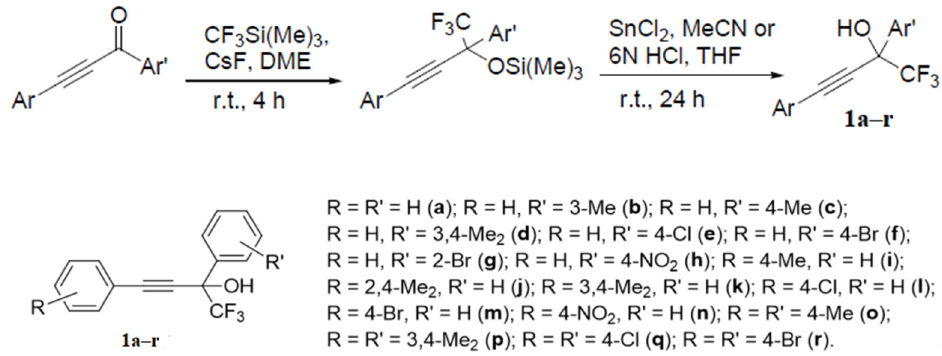
Figure 1. Starting CF 3 -propargyl alcohols used in this study.